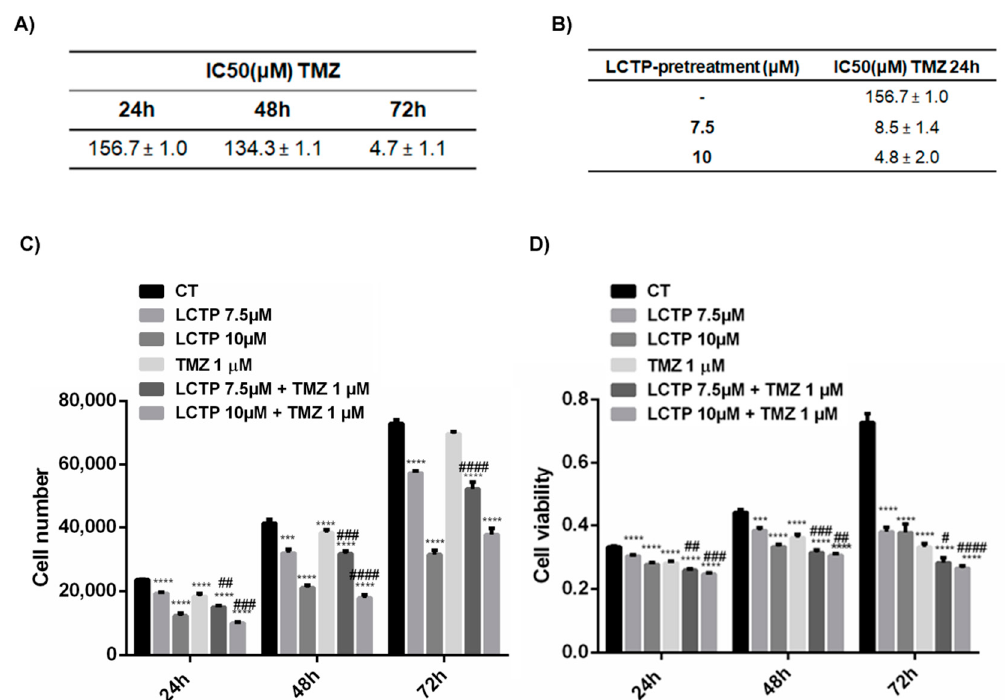
Figure 5. ( A ) IC50-values of U87Mg cells after 24, 48 and 72 h of incubation with TMZ. ( B ) IC50-values Figure 5. ( A ). IC50-values of U87Mg cells after 24, 48 and 72 h of incubation with TMZ. ( B ). of TMZ at 24 h of U87Mg cells pre-treated with LCTP 7.5 and 10 µ M for 24 h. ( C ) Synergistic e ff ect of IC50-values of TMZ at 24 h of U87Mg cells pre-treated with LCTP 7.5 and 10 µM for 24 h. ( C ). LCTP and conventional chemotherapy TMZ ongrowth of U87Mg cells. Values are the means ± SEM Synergistic effect of LCTP and conventional chemotherapy TMZ on growth of U87Mg cells. Values of 3 individual determinations. # p -value compared to cells treated with TMZ alone. ( D ) Synergistic are the means ± SEM of 3 individual determinations. Unpaired t -test, * p -value < 0.05 compared to e ff ect of LCTP and conventional chemotherapy TMZ oncell viability of U87Mg cells. Values are the control cells and # p -value compared to cells treated with TMZ alone. ( D ). Synergistic effect of LCTP means ± SEM of 3 individual determinations. # p -value < 0.05 compared to cells treated with TMZ and conventional chemotherapy TMZ on cell viability of U87Mg cells. Values are the means ± SEM of alone. According to GraphPad Prism, # p -value 0.01 to 0.05 (significant), ## p -value 0.001 to 0.01 3 individual determinations. Unpaired t -test, * p -value < 0.05 compared to control cells and # p -value (very significant), *** or ### p -value 0.0001 to 0.001 (Extremely significant), **** or #### p -value < 0.0001 < 0.05 compared to cells treated with TMZ alone. (Extremely